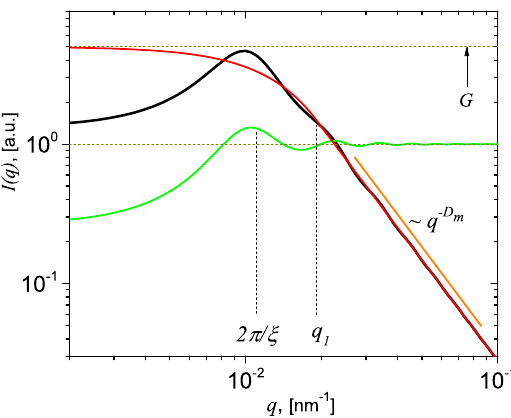
Figure 2. (Color online) Graphical representation of the total scattering intensity I ( q ) (black) given by model described in Equation (12) (black), the form factor P ( q ) (red) given by Equation (9) and the structure factor S ( q ) (green) given by Equation (8) at chosen values of the fitting parameters: R g = 100 nm, D m = 2.4, ξ = 550 nm, G = 5 and k = 2.8. Horizontal lines represent the asymptotic values of form factor at low q (upper line) and of structure factor at high q (lower line). The vertical lines show the position of first maxima in the structure factor ( q (cid:39) 2 π / ξ ) and of the transition point q 1 given by Equation (10), between the Guinier and Porod regimes.